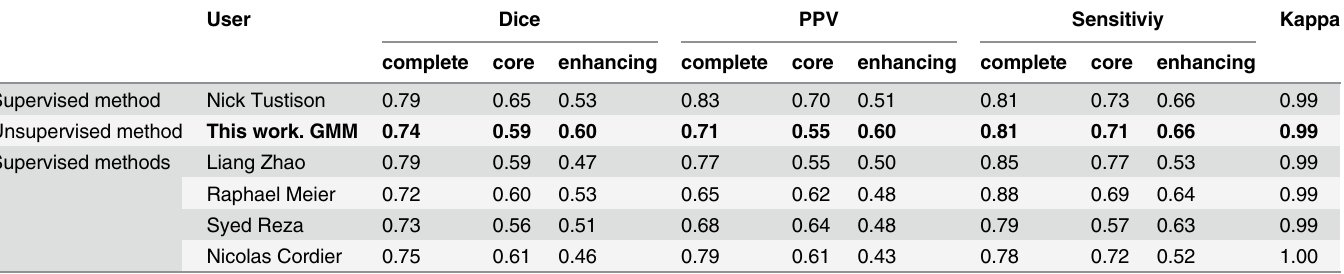
Table 4. Ranking of the BRATS 2013 Leaderboard set and the position occupied by our proposed unsupervised segmentation framework with the GMM algorithm. User Dice PPV Sensitiviy Kappa complete core enhancing complete core enhancing complete core